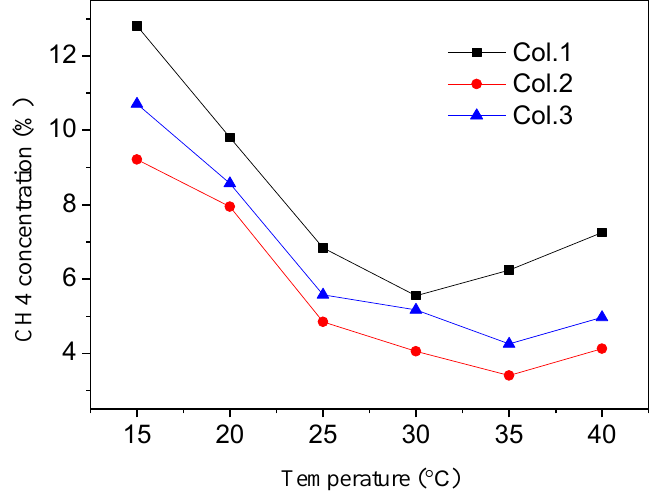
Figure 4. CH 4 concentration changes over temperature in columns.